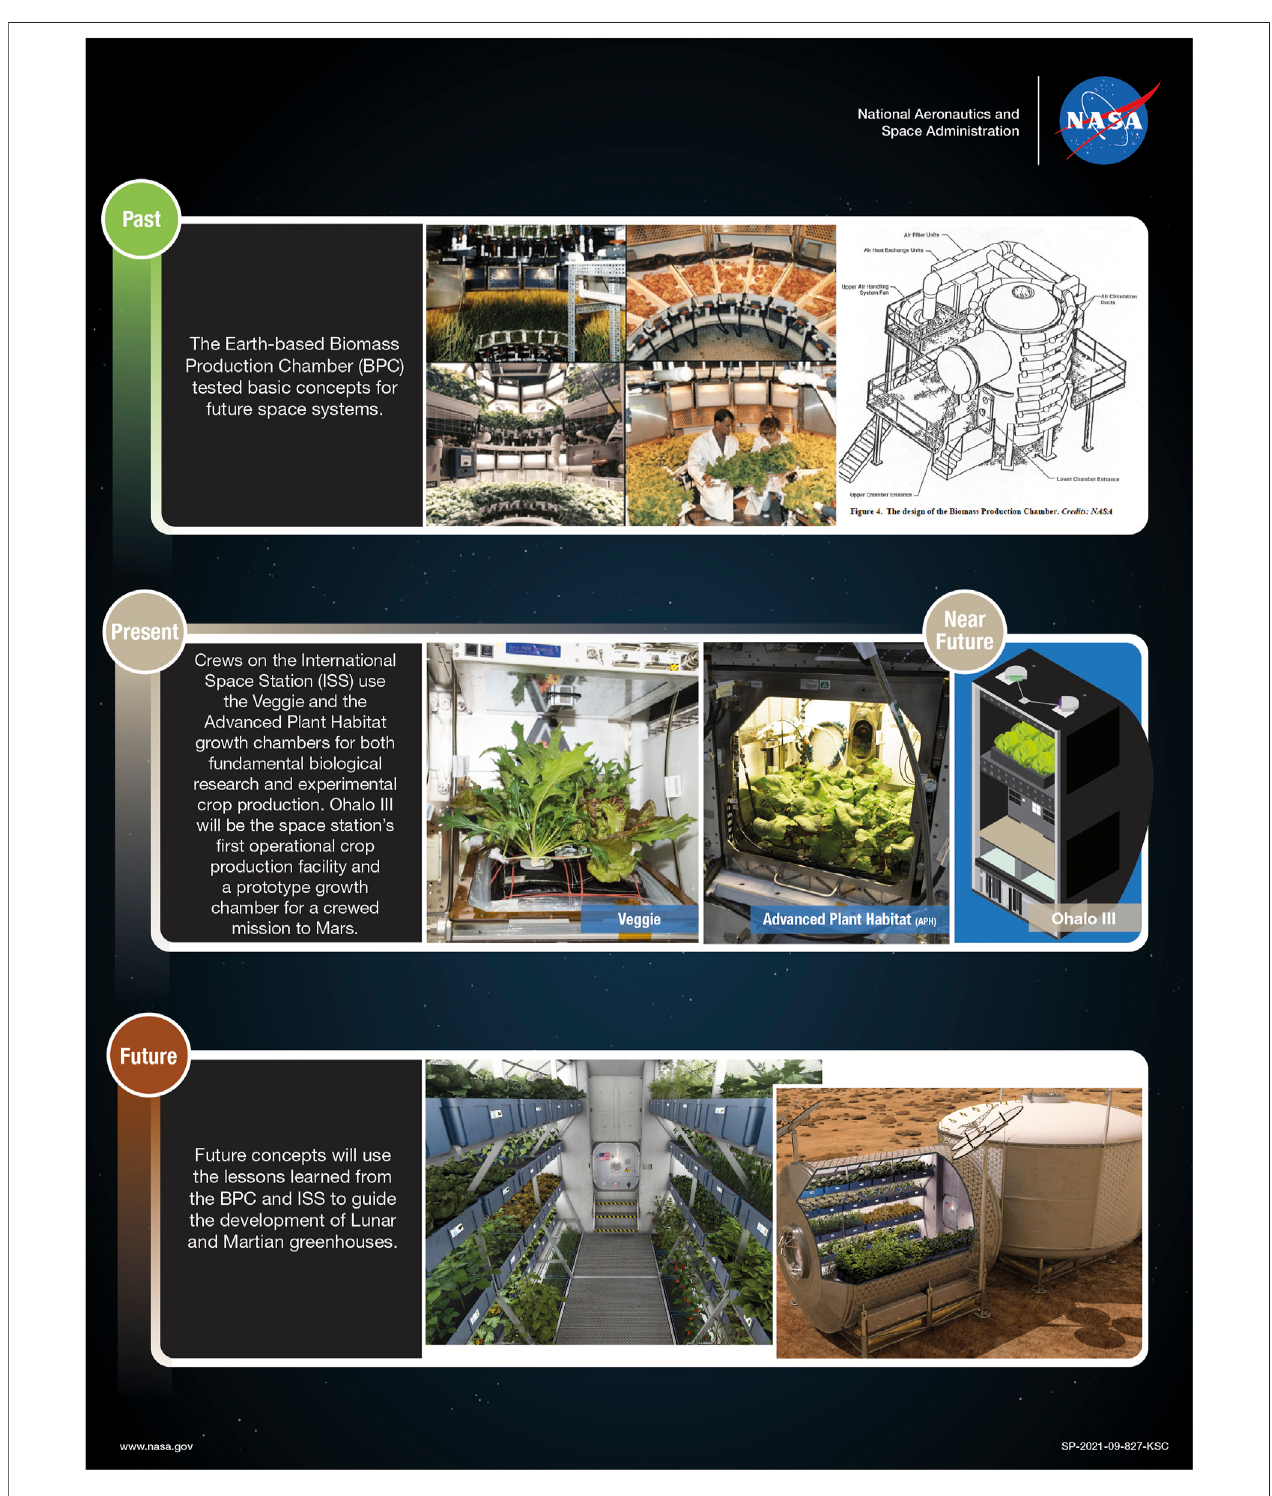
FIGURE1 | Examples of KSC ’ s prior, current and future space crop production platforms selected and designed to lead to crop production units destined for the Moon or Mars.